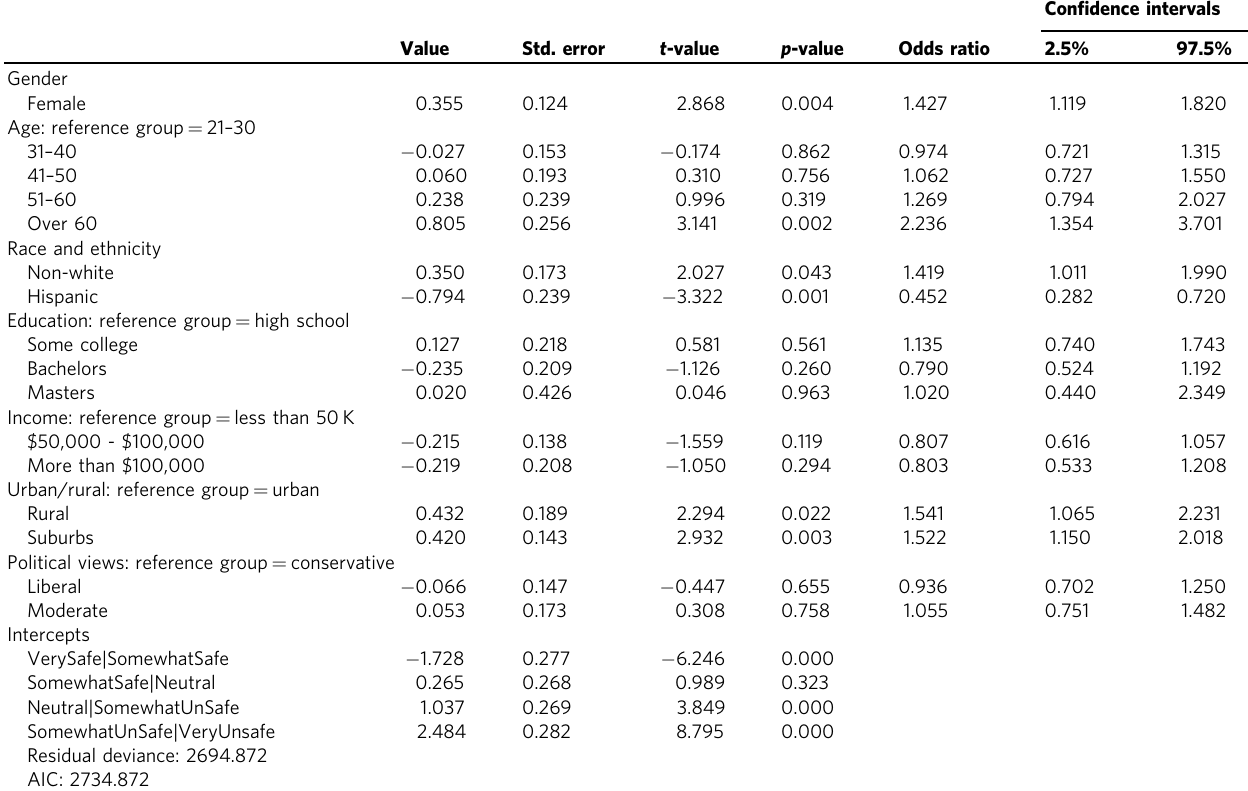
Table 2 Ordered logistic regression model estimates of the public ’ s perception of